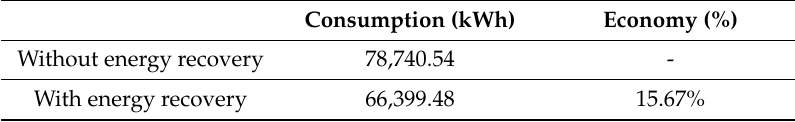
Table 6. Recoverable potential with limiting the storage